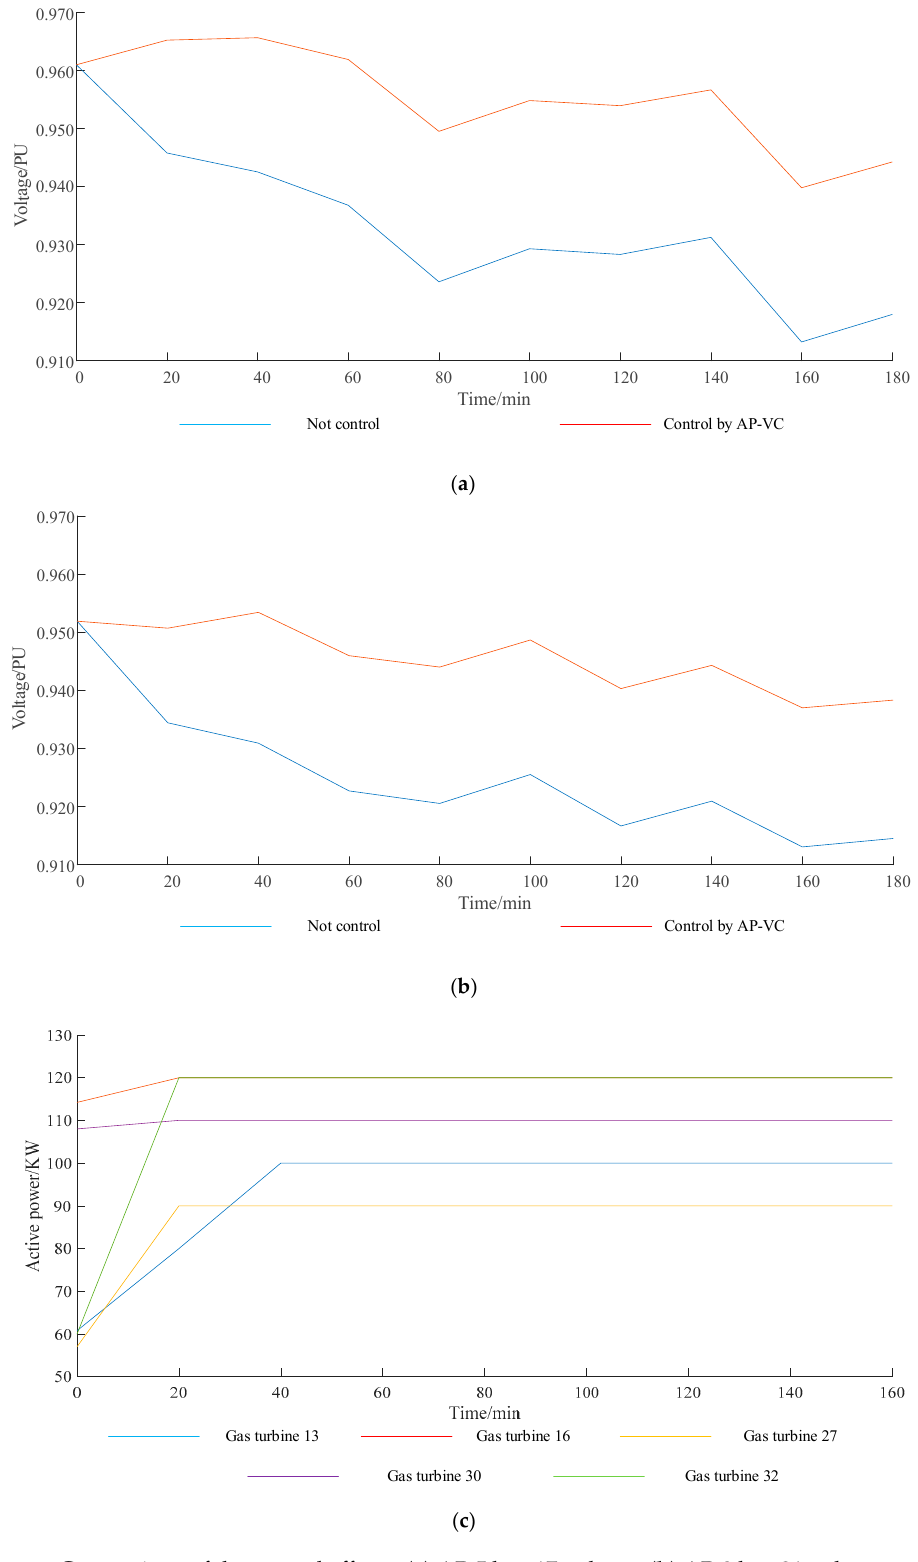
Figure 7. Comparison of the control effects: ( a ) AR 5 bus 17 voltage; ( b ) AR 3 bus 31 voltage; and ( c ) gas turbine active power output change. gas turbine active power output